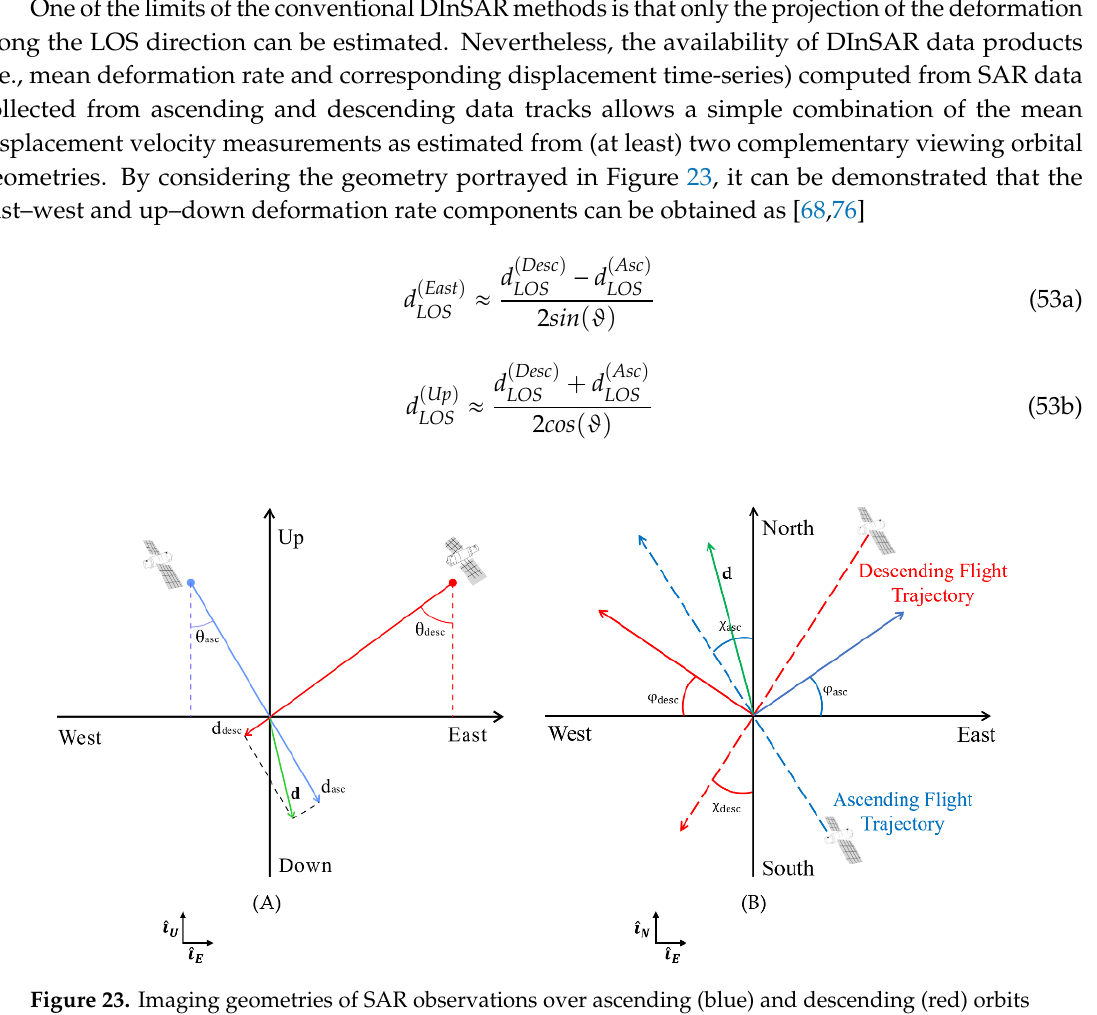
Figure 23. Imaging geometries of SAR observations over ascending (blue) and descending (red) orbits in the (A) east-vertical and (B) east-north planes, respectively.